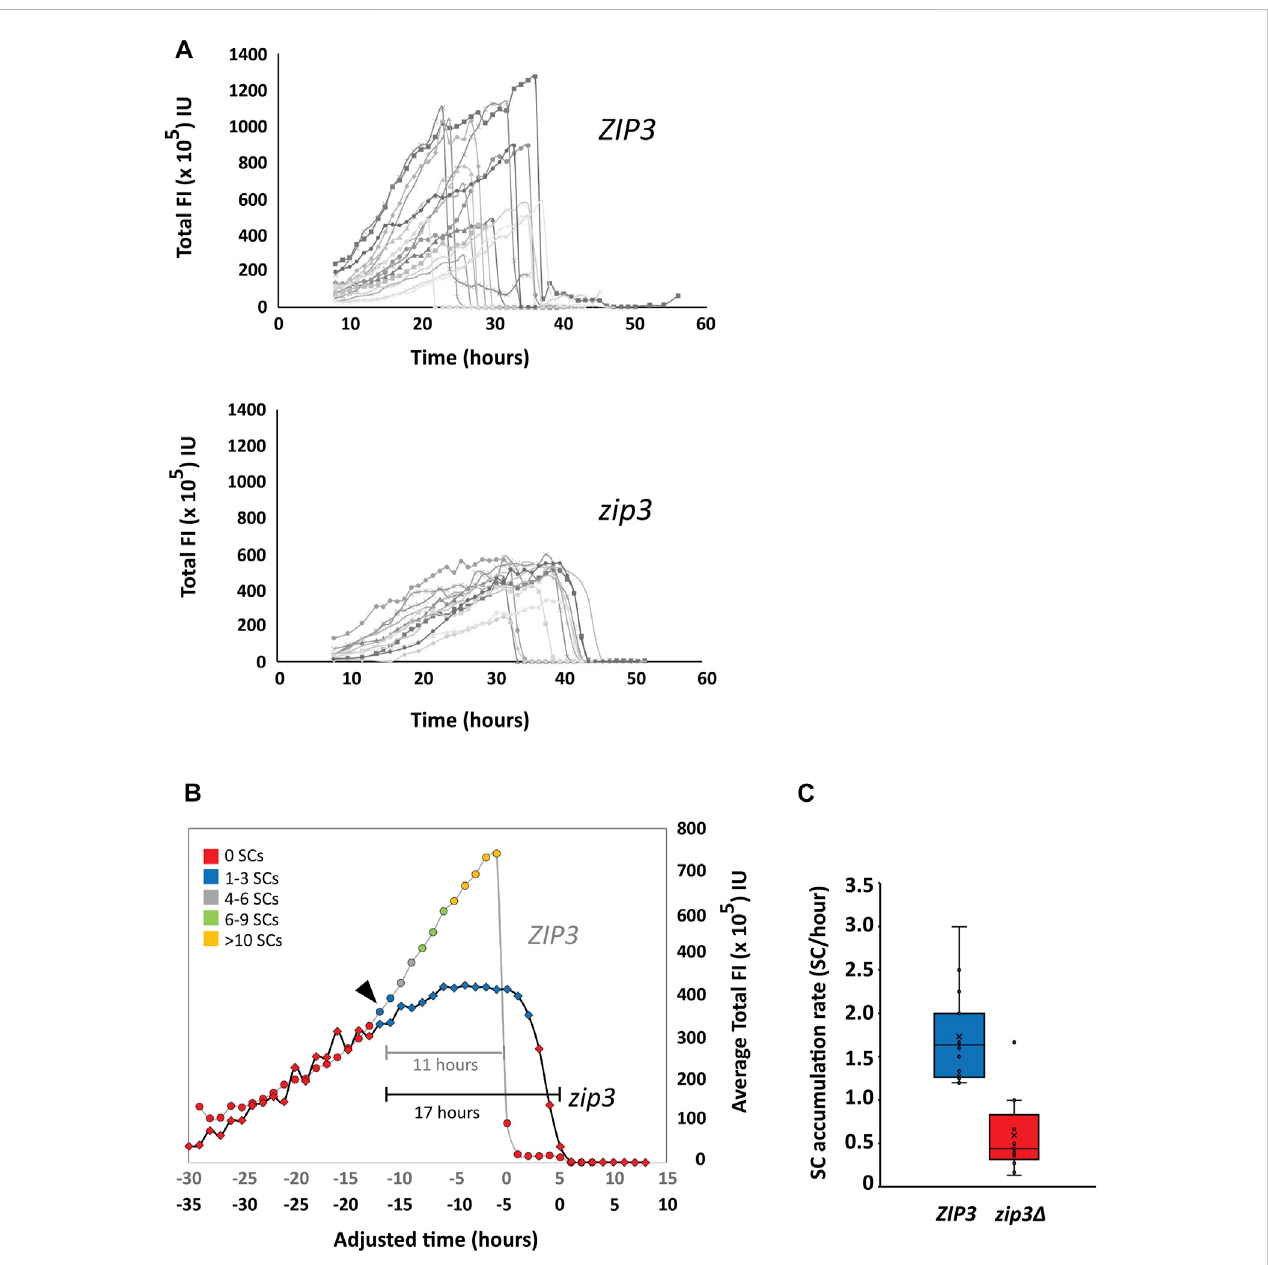
QuantitationofZip1levels. (A) TopPanel. Pro fi lesofZip1levelsfromindividualtime coursesof ZIP3 cellsexpressingZip1-GFP. n =16.3D opticalsections ofZip1-GFPinsporulatingstrainswereacquiredfor50 hat1-hintervalsstartingat8 hafterinductionofsporulation.Fluorescenceintensity(FI)wasmeasured as a proxy for Zip1 levels at each time point in arbitrary intensity units (IU). Bottom Panel. Pro fi les of Zip1 levels from individual time courses of zip3 Δ cells expressing Zip1-GFP. n = 13. (B) A comparison of average total Zip1 FI levels during prophase in ZIP3 (circles) vs. zip3 Δ (diamonds) strains. Given the asynchrony of synapsis initiation times, individual time courses for ZIP3 ( n = 16) and zip3 Δ ( n = 13) were aligned such that time zero represented the time at whichZip1-GFPwasdepleted.Thetimepointswereadjustedrelativetotime zeroandaverageZip1levelswerecalculatedforeachtimepointforbothstrains. These pro fi les were then aligned to each other based on the time synapsis is fi rst detected. Two adjusted time axes are presented for ZIP3 (grey) and zip3 Δ (black). The general number of SCs is distinguished with colored markers: Red — 0, Blue — 1 – 3, Gray — 4 – 6, Green — 7 – 9, and Orange — > 10 synapsed regions. TheblackarrowindicatestheZip1thresholdatwhichsynapsisis fi rstobserved.Bracketsshows lengthoftimeforsynapsisfor ZIP3 (gray)and zip3 Δ (black). (C) The rate of SC accumulation for ZIP3 (blue) and zip3 Δ (red). The rate was calculated by calculating the time it took to fi rst reach the maximum number of distinguishable